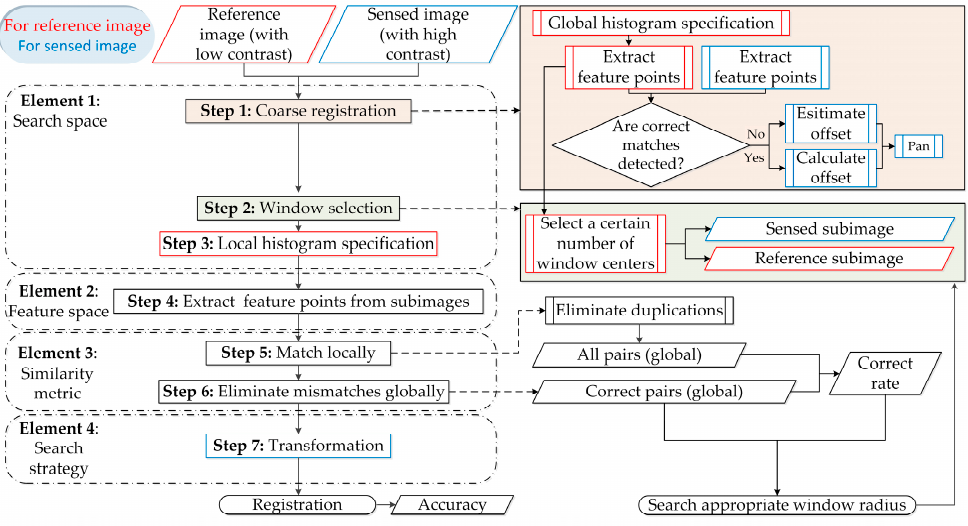
Figure 5. Flow chart of the proposed method.